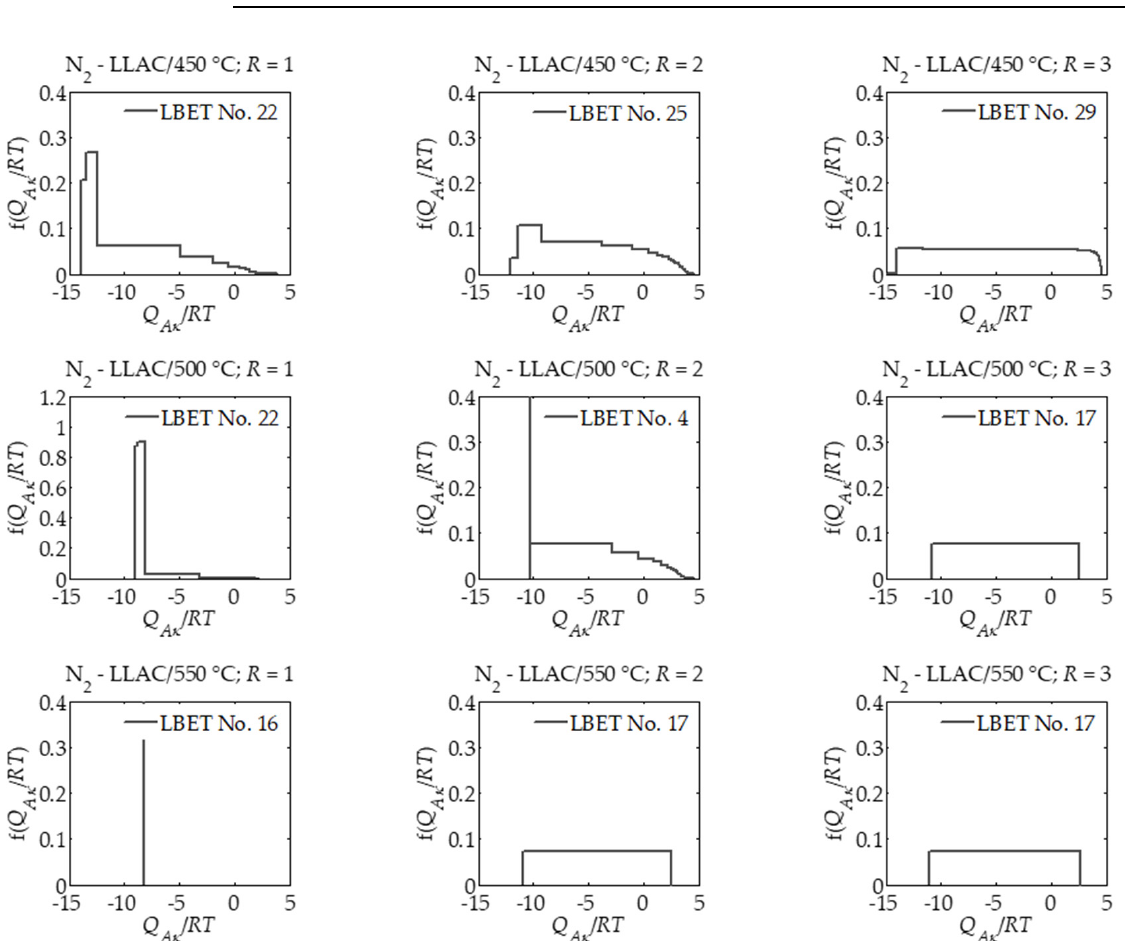
Figure 2. The adsorption energy distributions for the first adsorption layer determined for all analyzed samples of nitrogen- doped activated carbons prepared from lotus leaves by carbonization and chemical activation with sodium amide NaNH 2 on the basis of nitrogen adsorption isotherms via the LBET